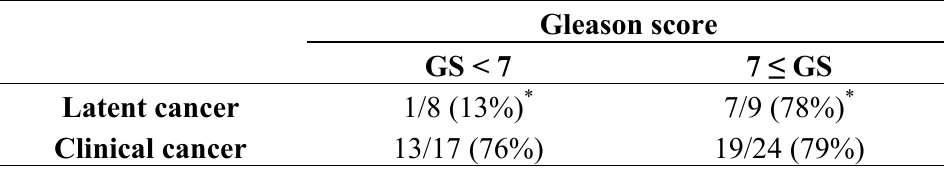
Table 3. The frequency of TSPY expression in lower Gleason grade cancer (GS < 7) and higher Gleason grades cancer (7 ≤ GS).